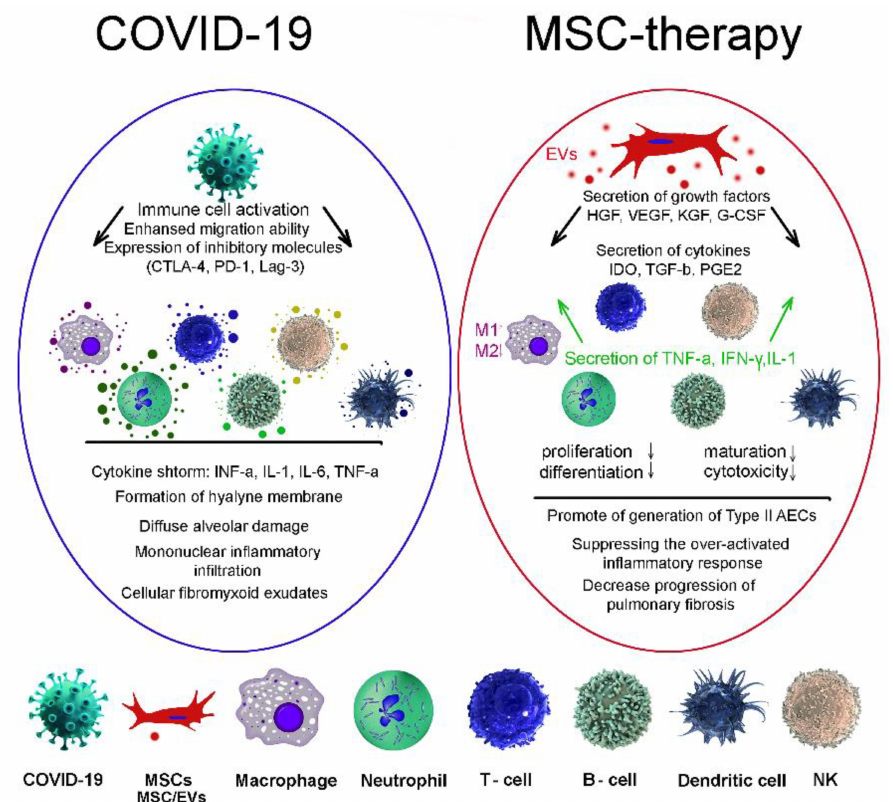
Figure 2. MSC therapies for treatment of coronavirus-induced lung injury. COVID-19, coronavirus; MSCs, mesenchymal stem/stromal cells; EVs, extracellular vesicles; macrophage; neutrophil; T-cell; B-cell; dendritic cell; NK, natural killer